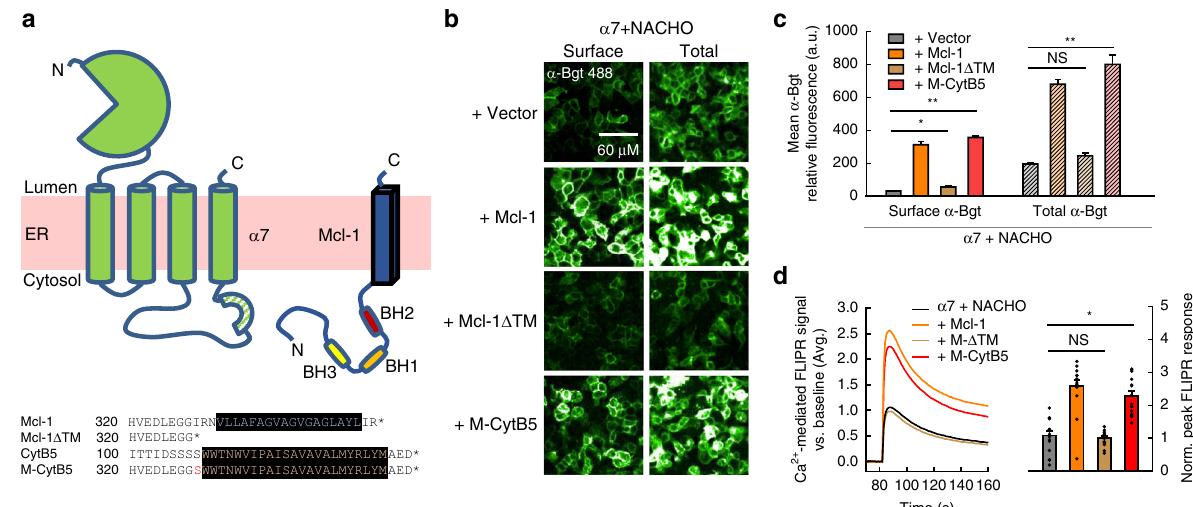
Fig. 3 ER-anchoring of the Mcl-1 TM segment is critical for regulation of α 7 nAChR assembly. a Topological illustration of the α 7 nAChR subunit and Mcl-1 within the ER membrane (top), and amino acid sequence alignment of various Mcl-1 constructs examined with transmembrane regions highlighted in black (bottom). b Fluorescent α -Bgt labeling of nonpermeabilized and permeabilized HEK293T cells cotransfected with cDNAs encoding α 7 and NACHO, along with empty vector, wild-type Mcl-1, a truncated Mcl-1 construct lacking the C-terminal TM segment (Mcl-1 Δ TM), or a chimeric Mcl-1 containing the TM sequence of cytochrome B5 in place of its own (M-CytB5) at a 1:3:4 respective ratio. c Quanti fi cation of fl uorescence intensity from surface and total labeling of α 7 nAChRs by α -Bgt when coexpressed with NACHO and various Mcl-1 constructs ( n = 5, * p < 0.01, ** p < 0.001). Increases in total α -Bgt labeling were signi fi cant ( α = 0.017) for cells expressing Mcl-1 and M-CytB5, but not Mcl-1 Δ TM ( p = 0.04), atop α 7 and NACHO. The same cDNA combinations were transfected at different passage numbers and yielded similar results. d Averaged FLIPR traces showing 100 µ M nicotine-evoked Ca 2 + fl ux through HEK293T cells cotransfected with cDNAs encoding the α 7 nAChR, NACHO, and various Mcl-1 constructs at a 1:1:5 respective ratio (left). Also shown is the mean peak response above baseline ( n = 15, * p < 1e − 5 ), normalized to the background fl uorescence signal (right). Increases in FLIPR response were signi fi cant for cells expressing Mcl-1 and M-CytB5, but not Mcl-1 Δ TM ( p = 0.60), atop α 7 and NACHO. Data shown are from an individual experiment that was replicated. All data are means ± SEM; p values from two-sample t